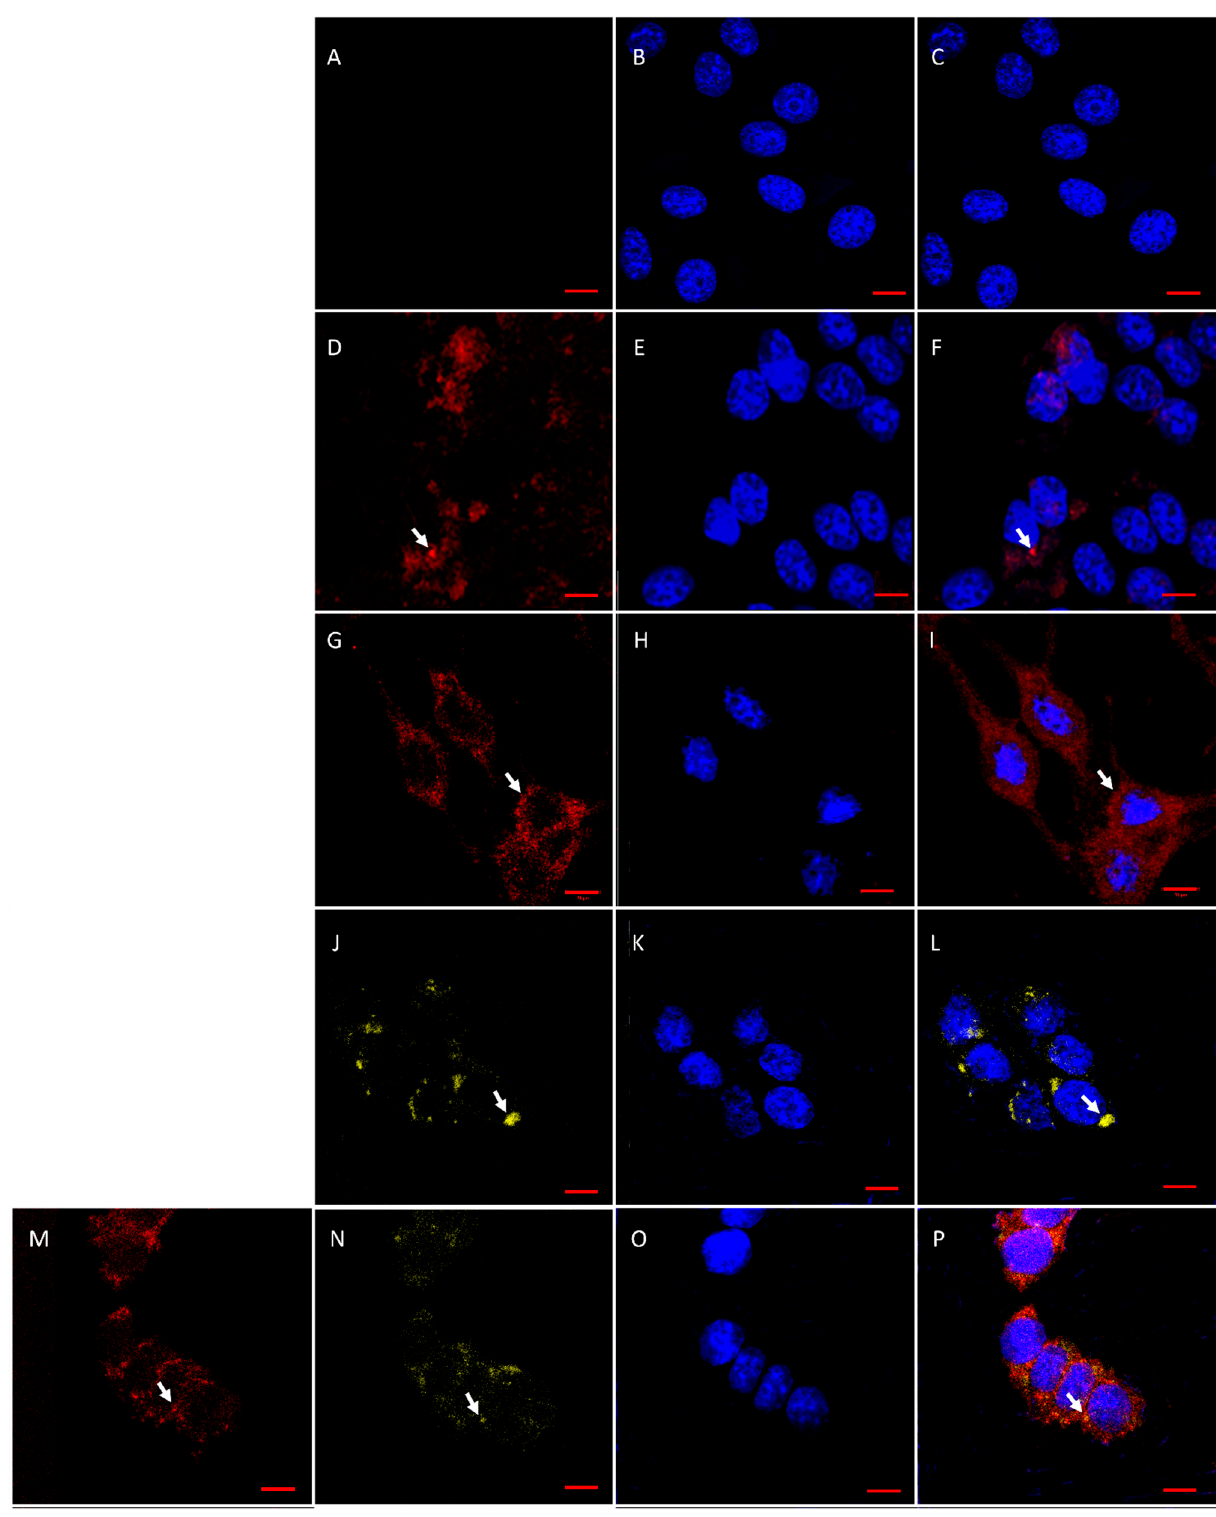
Figure 7. PUUV N and Gn/Gc protein detection in A549 cells treated with MVs. A549 cells (5 × 10 4 cells/per well) were treated with MVs, containing PUUV N, Gn/Gc or their combination together with red fluorescent protein Katushka2S. Treated cells were incubated with primary rabbit anti-N protein or mouse anti-Gc protein antibodies followed by secondary donkey anti-rabbit IgG (H + L) Alexa Fluor 647 or donkey anti-mouse IgG (H + L) Alexa Fluor 555 to previous primary antibodies, respectively. ( A )—A549 cells treated with MVs derived from non-transduced MSCs; ( B )—The nuclei of A549 cells treated with MVs derived from non-transduced MSCs; ( C )—Merged images (A